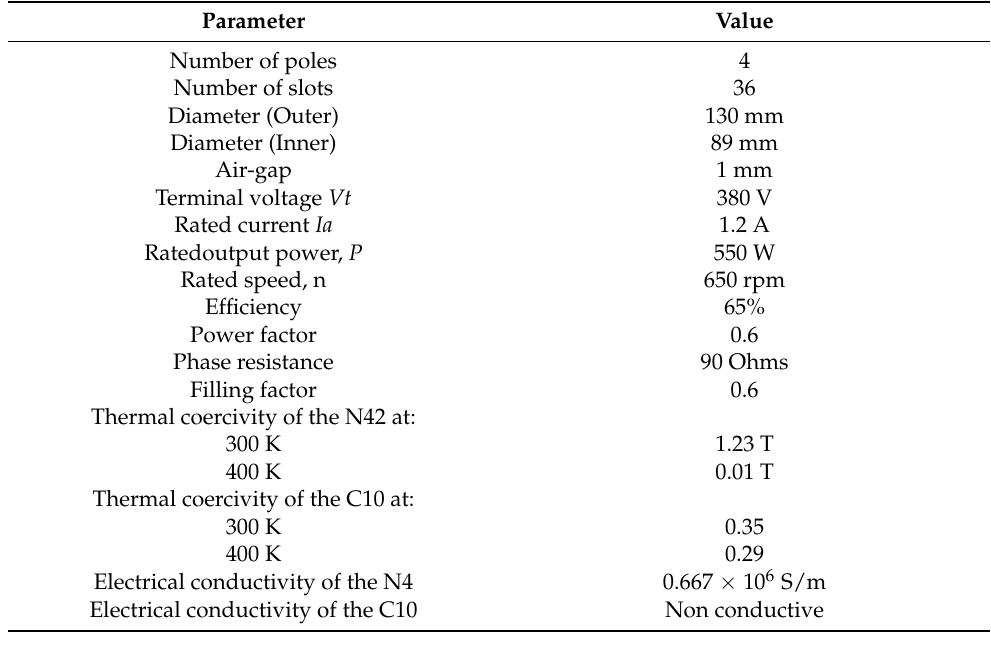
Table 1. Basic parameters of the conventional squirrel-cage induction motor.